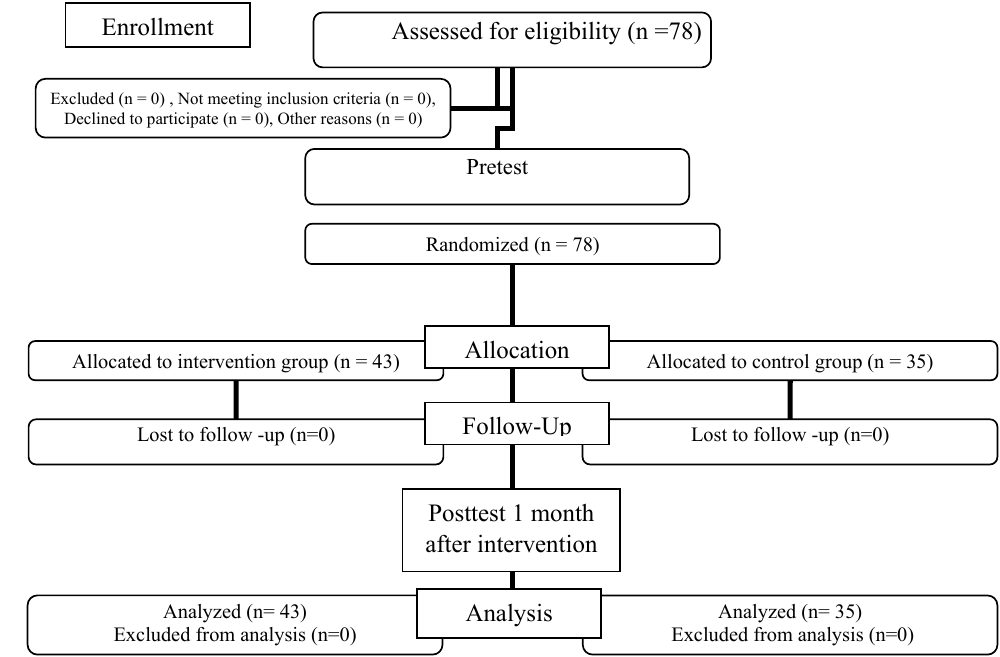
Figure 1. The consort flow diagram of